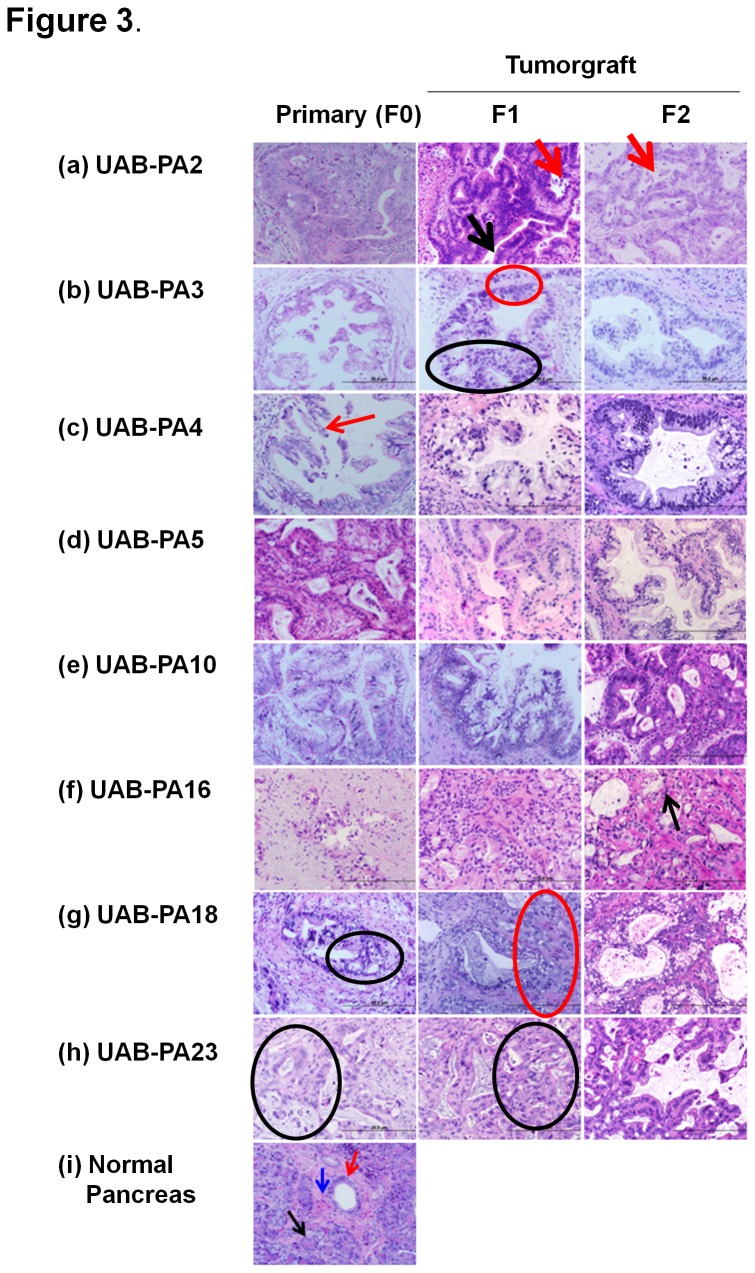
Histological evaluation of eight F1 and F2 tumorgrafts demonstrates morphological fidelity of these tumors with the F0 tumors from which they were derived.Detailed descriptions of histological characteristics are included in the Results section. Histological evaluation of an additional twelve models are presented and described in the Supporting Information; Figure S2.